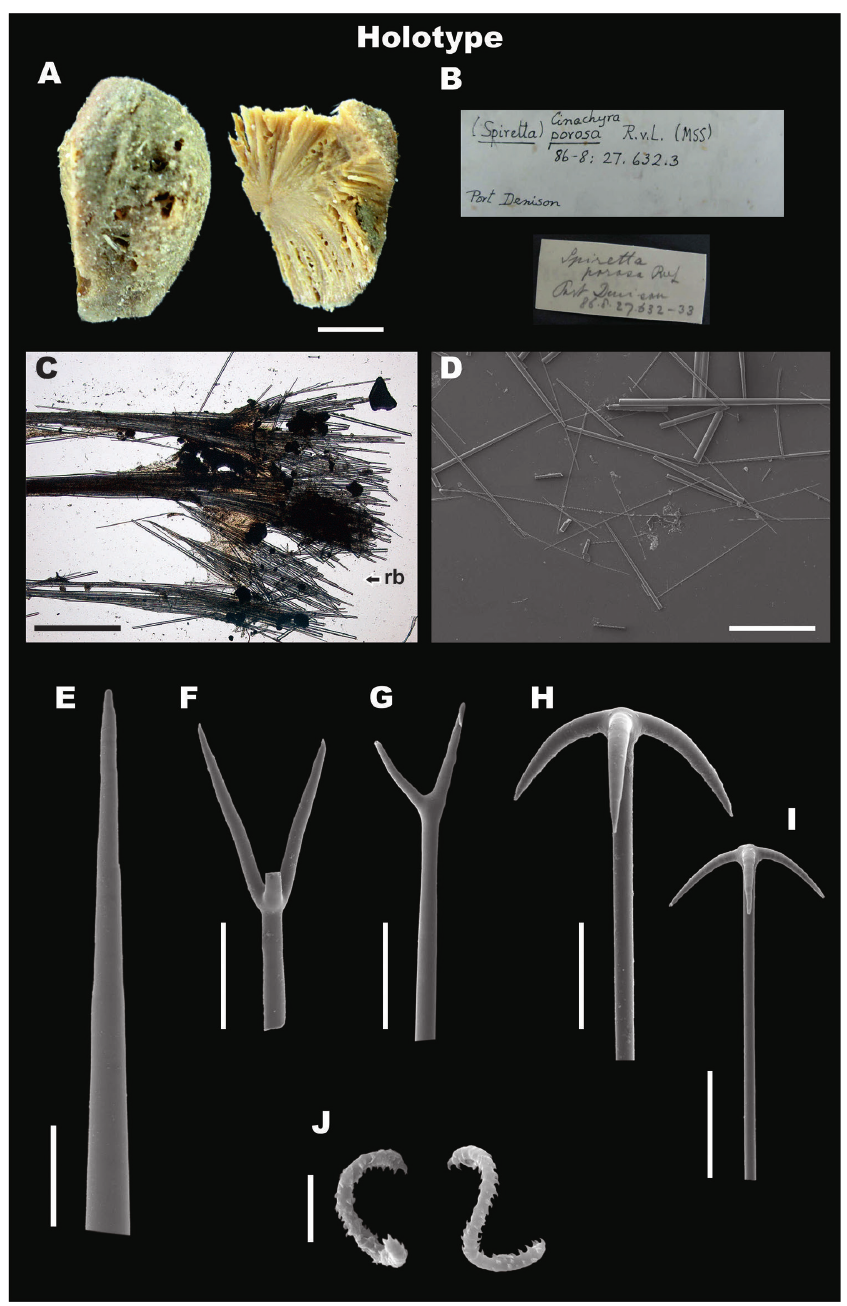
Figure 9. Cinachyrella porosa . Holotype NHMUK1886.8.29.632-633, Port Denison, Australia. A pre- served material showing porocalices and internal structure B Labels of the type specimen C skeleton D elec- tron micrograph showing oxea fragments and triaenes rhabds E oxea, end detail F protriaene G prodiaene H, I anatriaenes J sigmaspires. Scale bars: 1 cm ( A, C ); 500 µm ( D ); 50 µm ( E ); 40 µm ( F–I ); 5 µm ( J